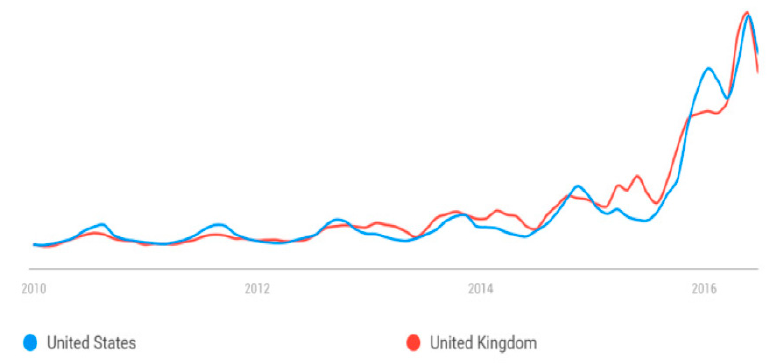
Figure 2. Google search trends for bomber jackets in UK and US (Boone 2016).